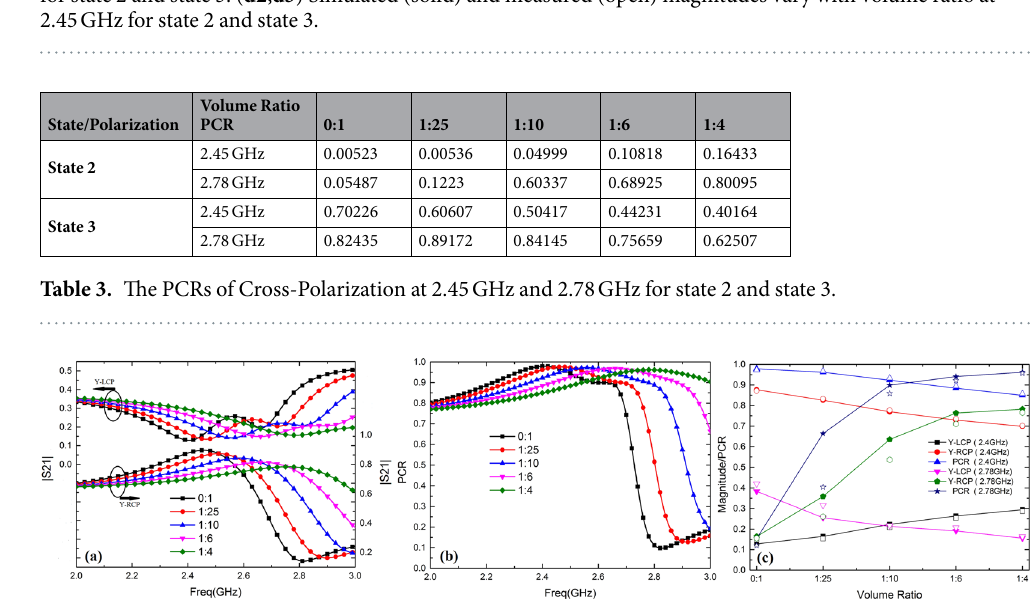
Figure 4. ( a ) Simulated transmission of Y-CP ( b ) Calculated PCRs vary with volume ratio ( c ) Simulated (solid) and measured (open) magnitudes vary with volume ratio at 2.4 GHz and 2.78 GHz